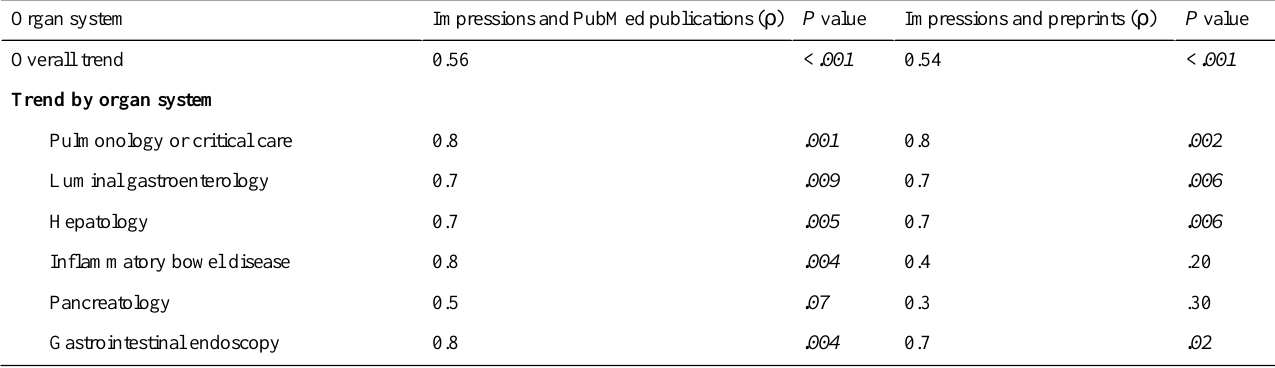
Table 3. Correlation between Twitter activity (impressions) and PubMed publications and between Twitter activity (impressions) and preprints by organ system. Italicized values indicate statistical